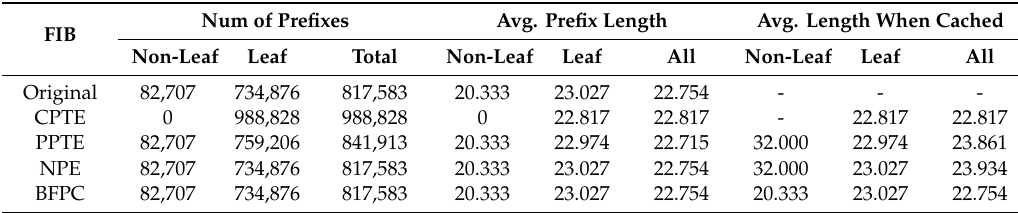
Table 1. The characteristics of FIBs used in prefix caching schemes.